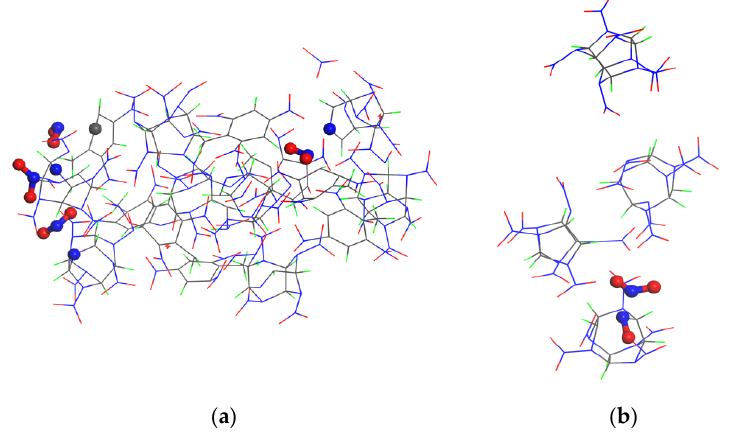
Figure 7. Molecular structure snapshots of the (a) CL-20/TNT cocrystal (3 km/s 2.0 ps) and (b) CL-20 crystal (2 km/s 0.8 ps). C, H, O and N atoms are shown in grey, green, red and blue, respectively.